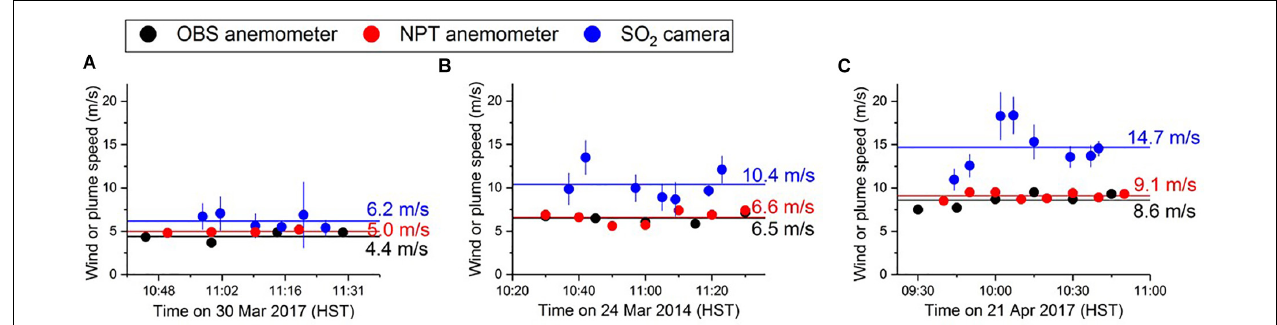
FIGURE 9 | (A–C) Comparison of wind speeds derived from SO 2 camera with wind speeds from meteorological stations OBS (10 m agl on rim of caldera) and NPT (3 m agl on floor of caldera; Figure 2 ) on three different days. Anemometer wind speeds are averaged over the intervals at which they are plotted. The SO 2 camera wind speed was derived and plotted at times only coincident with DOAS vehicle traverse measurements performed on Crater Rim Drive.